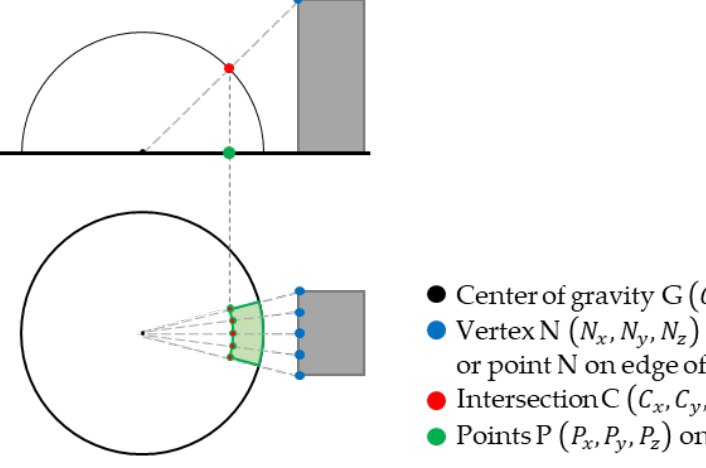
(cid:0) (cid:1) P x , P y , P z on the orthographic image.